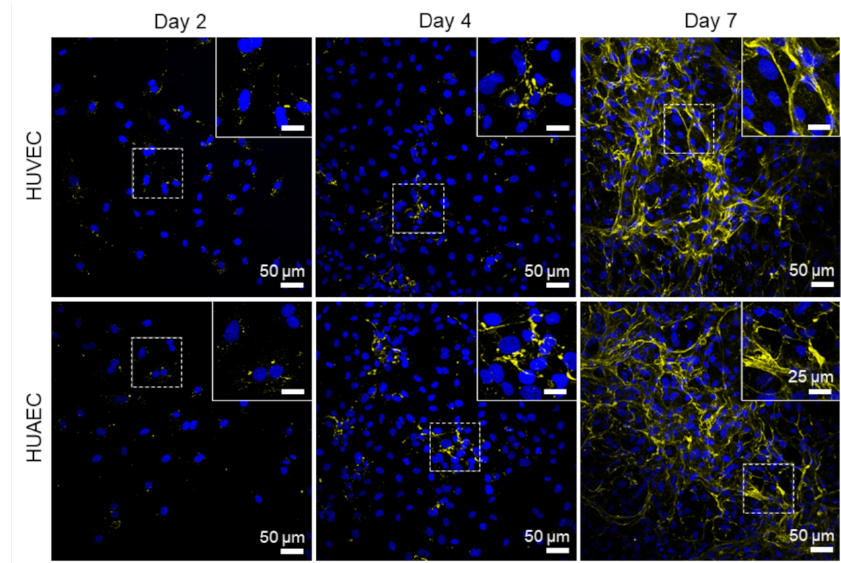
Figure 7. Expression of collagen I-V by endothelial cells. Human umbilical cord-derived endothelial cells from veins (HUVEC) or arteries (HUAEC) were seeded at a density of 15,000 cells/well at day 0 and cultivated for 2, 4, and 7 days. While only traces of collagen were detected at day 2, the expression increased with increasing cultivation time, leading to large networks of collagen fibers at day 7 with cells from both sources. Fluorescent images were taken at 20-fold primary magnification. Scale bar represents 50 µ m, and 25 µ m in the magnified image sections in the upper right corner of each image. Squares with dashed lines indicate the image region that was magnified.